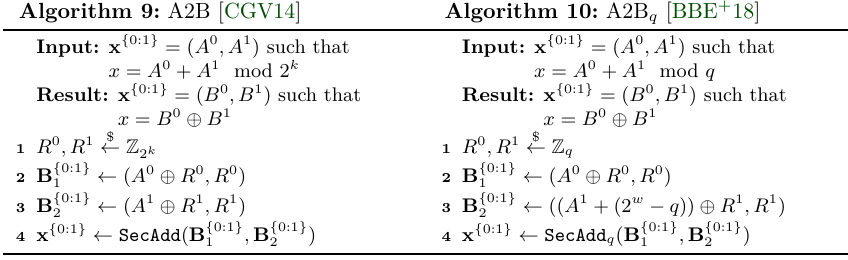
Algorithm 10: A2B q [BBE +